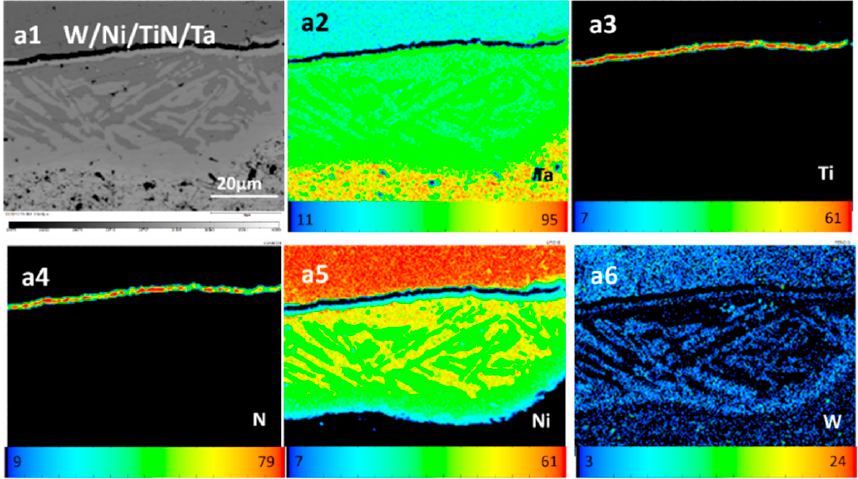
Figure 9. Interface composition distribution of W/Ni/TiN/Ta-laminated composite joined at 1200 °C: ( a1 ) morphology; ( a2 ) Ta; ( a3 ) Ti; ( a4 ) N; ( a5 ) Ni; and ( a6 ) W.